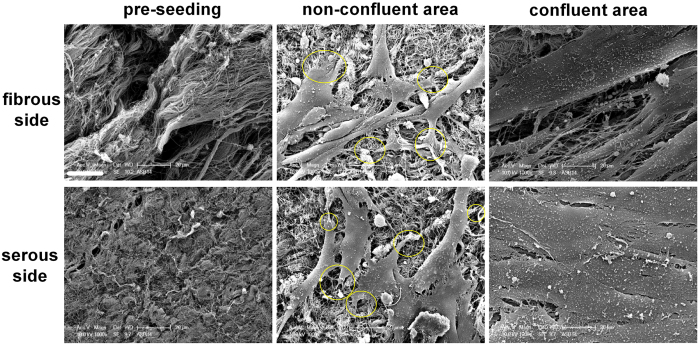
Scanning electron microscope (SEM) images of ASB-14 scaffolds before and after cell seeding (1000×).ASB-14 scaffolds possess a distinct sidedness. Collagen forms thicker bundles on fibrous side, while oriented collagen fibers on the serous side forming a smooth surface. Circles indicate the attachment points of cells to the material surface. The sidedness is no longer present following seeding. Scale bar represents 20 μm (n = 4).